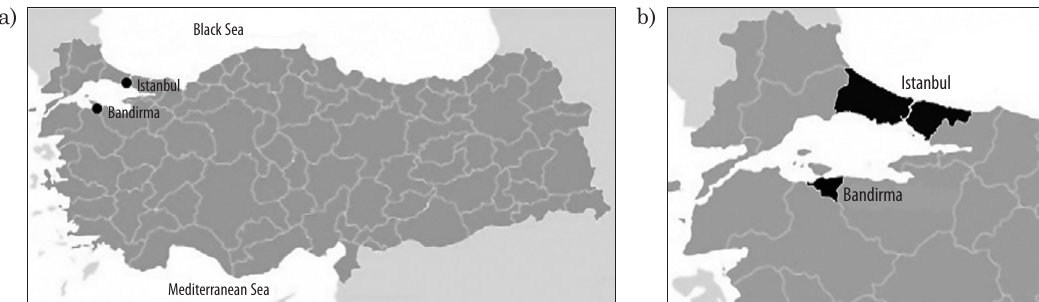
Fig. 1. The location of the IMA and BND in Turkey – in Marmara region (a, b)